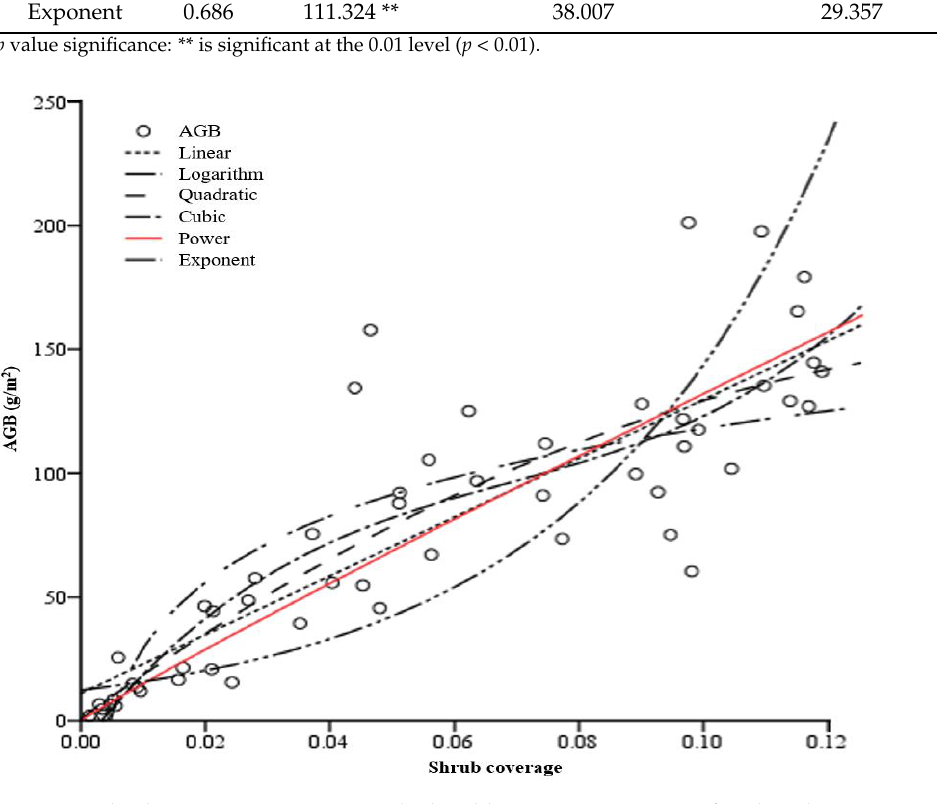
Figure 7. Shrub vegetation coverage calculated by UAV RGB images fitted to the AGB curve in sample plots.